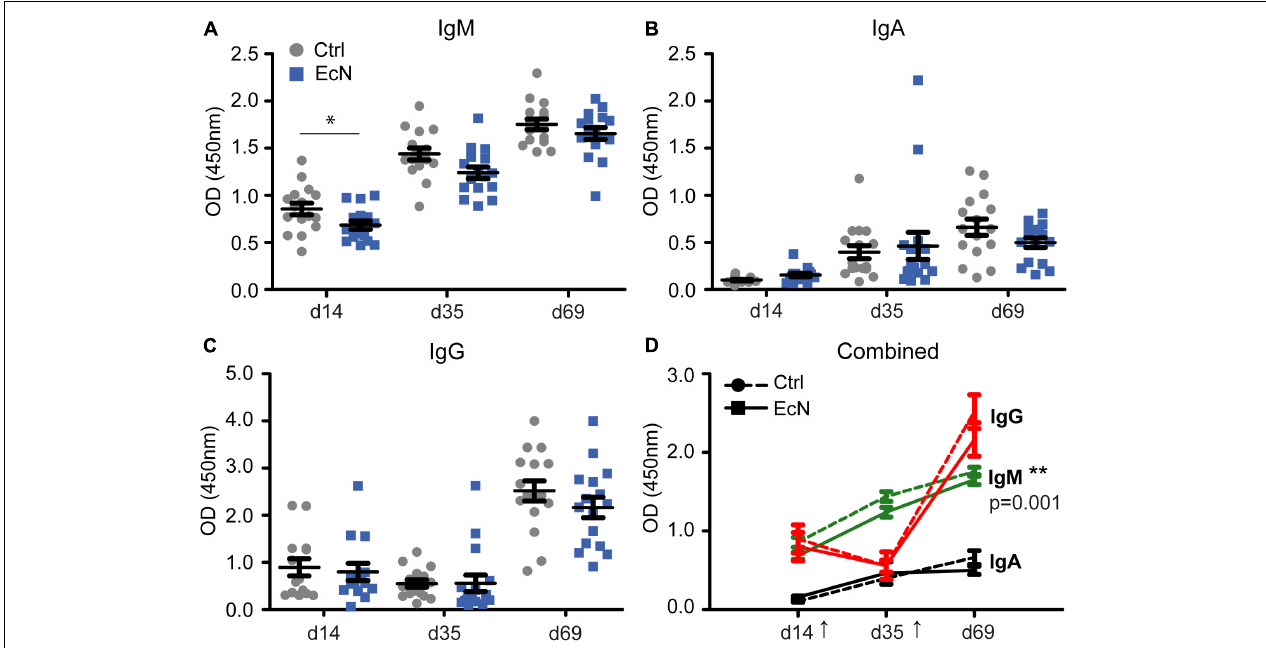
FIGURE 6 | Serum levels of Salmonella -specific IgM, IgA, and IgG (A–C) prior to vaccination (day 14), 2 weeks after the initial vaccination (day 35), and 3 weeks after the booster vaccination (day 69). Plot (D) incorporates all results (A–C) , with the arrows indicating the time of vaccination (days 21 and 45). Every symbol represents a single animal. Two EcN-treated animals (squares; (cid:4) , solid lines) and two control animals (circles; • , dashed lines) were randomly selected from every pen, and followed over time ( n = 16 per treatment group). Data are presented as the mean ± standard error of the mean (SEM). Asterisks are used to demonstrate significant differences between treatment groups after taking into account single time points ( ∗ p < 0.05 and ** p < 0.01), and p -values indicate significant differences between treatment groups over time.